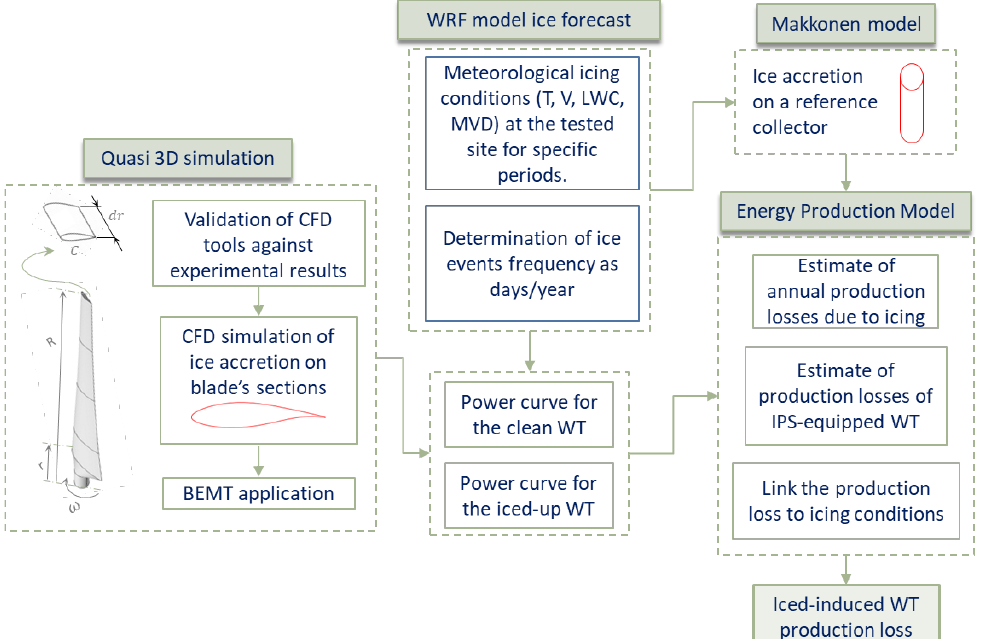
Figure 10. Strategy for the assessment of production losses due to icing using the Quasi 3D simula- tion and numerical weather prediction. @Fahed Martini. and numerical weather prediction. @Fahed